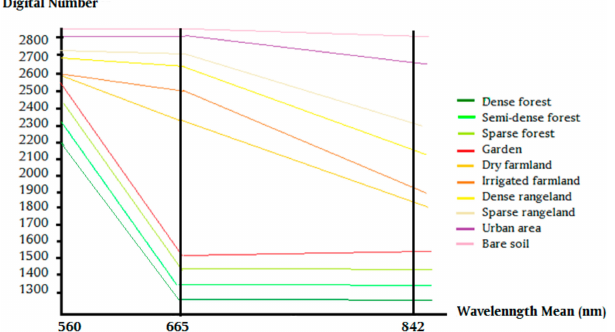
Figure 2. The spectral properties of di ff erent land covers.